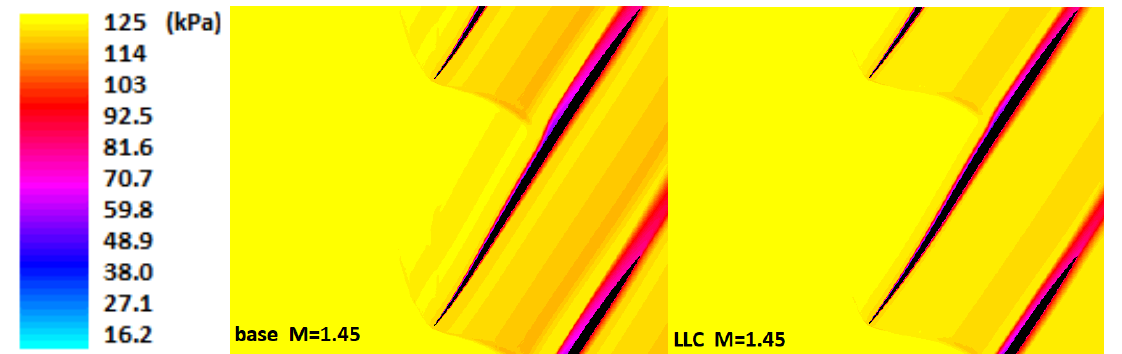
Figure 15. Total pressure contours (kPa) of profiles with LLC at Mach